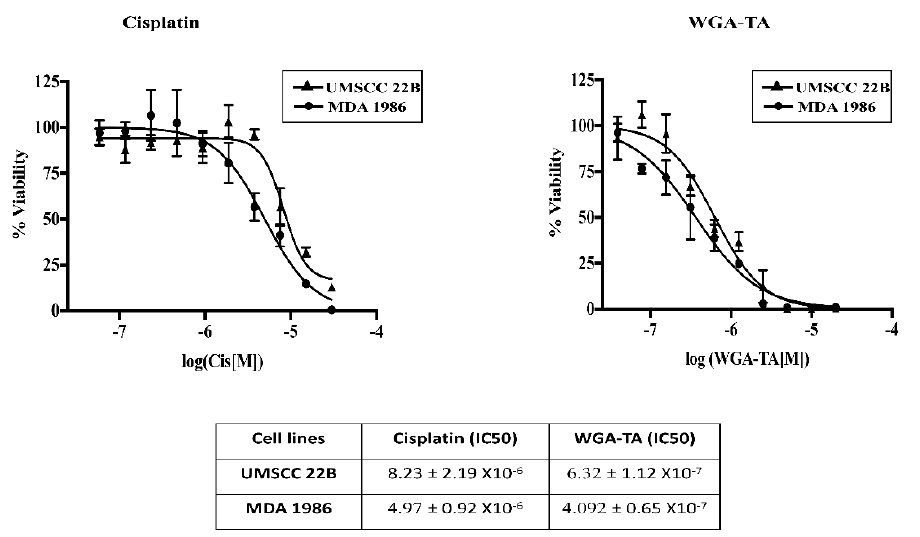
Figure 1. MDA-1986 and UMSCC-22B cells were treated with varying concentrations of either cisplatin alone or WGA-TA alone and the cell viability after 72 h was measured via MTS assay. The IC50 values ( µ M) shown below were calculated using GraphPad Prism.